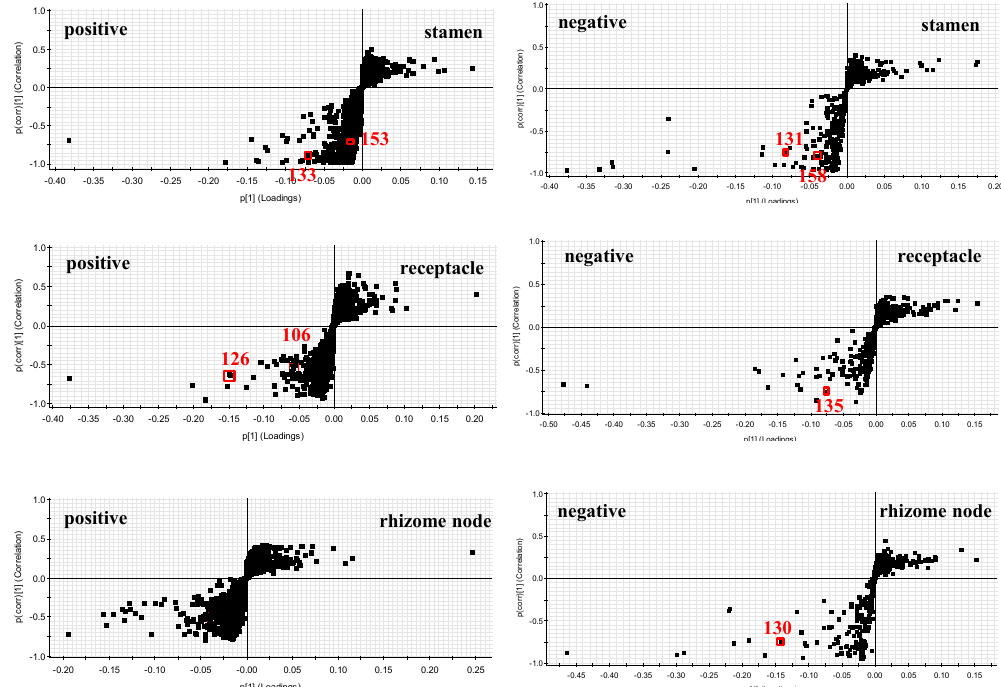
Figure 6. The OPLS-DA/S-plots of Sem , Fol , Plu , Sta , Rec , and RN of lotus. The points on the lower left represent the compounds in this part, and the points at the higher right represent the compounds in the other five parts. The biomarkers and their compound numbers are marked in red.